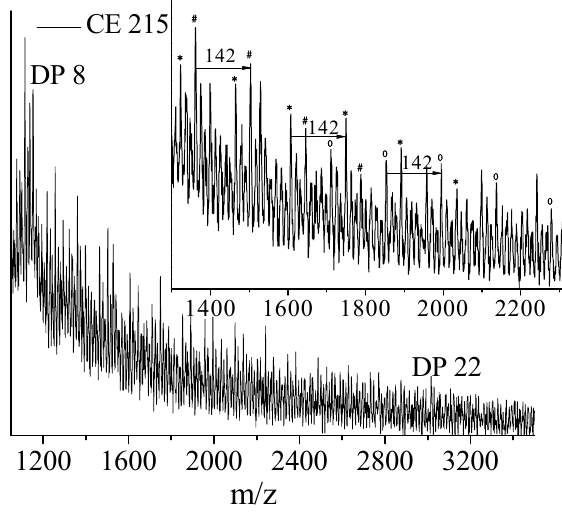
Figure 3. MALDI spectra of CE 215 reactive oligomer (inset: details showing the